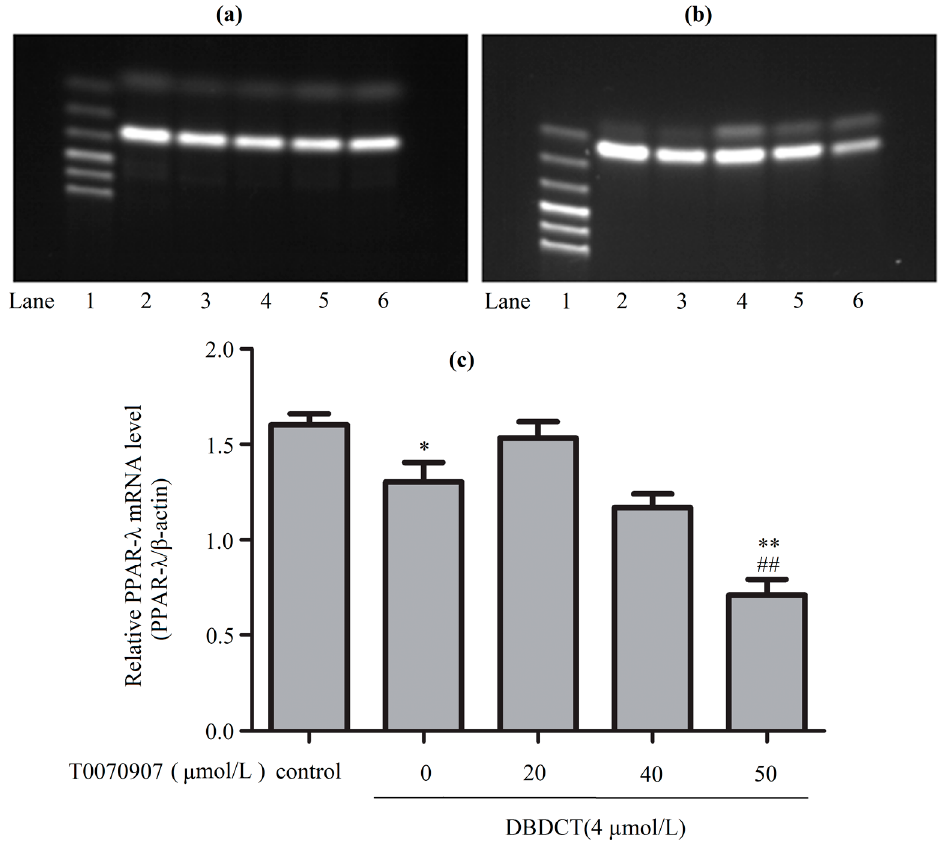
Figure 8. The PPAR- λ expression levels of mRNA in BRL cells with the treatment of T0070907 and DBDCT. ( a , b ) The RT-PCR results of β -actin and PPAR- λ (Lanes 1–6: Marker, Control, 4 µ mol/L of DBDCT, 20 µ mol/L of T0070907 + 4 µ mol/L of DBDCT, 40 µ mol/L of T0070907 + 4 µ mol/L of DBDCT, and 50 µ mol/L of T0070907 + 4 µ mol/L of DBDCT); ( c ) Relative mRNA levels of PPAR- λ in BRL cells.